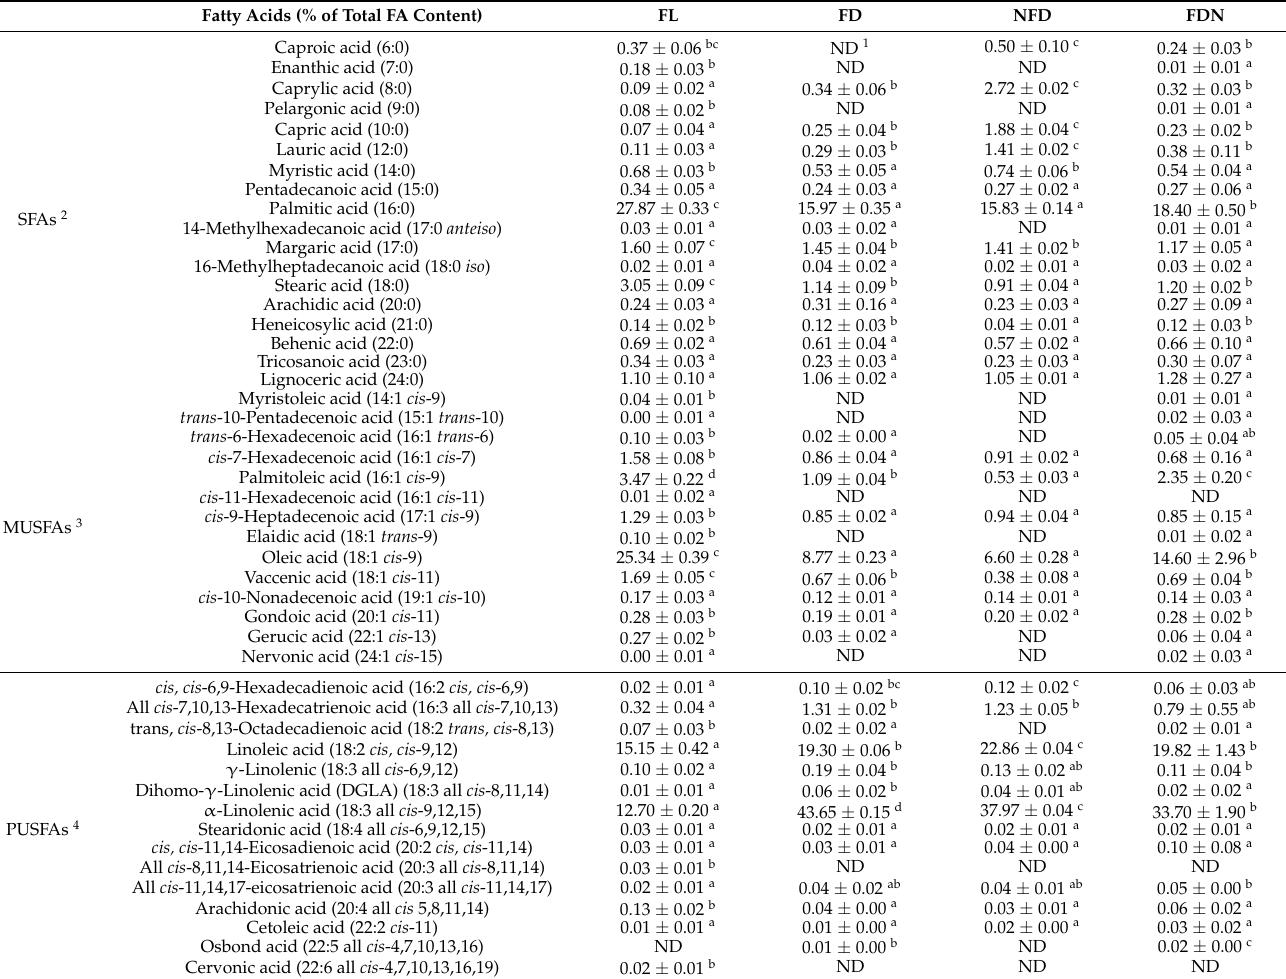
Data are reported as mean ± SD ( n = 3). a,b,c,d Different letters show that there is a significant difference ( p ≤ 0.05), according to one-way ANOVA and Tukey’s HSD test; 1 Not detected; 2 Saturated fatty acids; 3 Monounsaturated fatty acids; 4 Polyunsaturated fatty